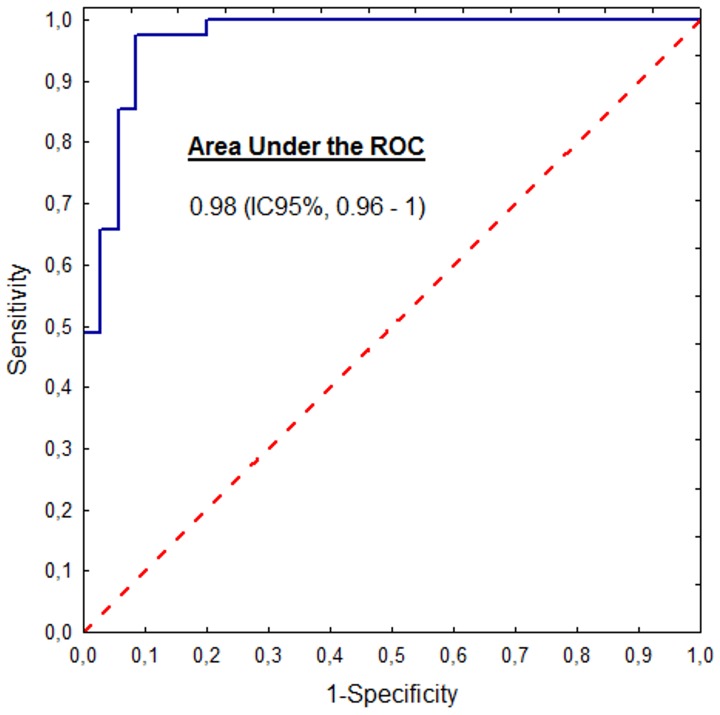
ROC curve of PPD for discrimination of infants with or without significant patent ductus arteriosus.For the optimal cut-off of PPD ≥1.65 deg/cm, the area under ROC curve was 0.98 (0.96–1) with a sensitivity of 94.2% and a specificity of 98.3%.